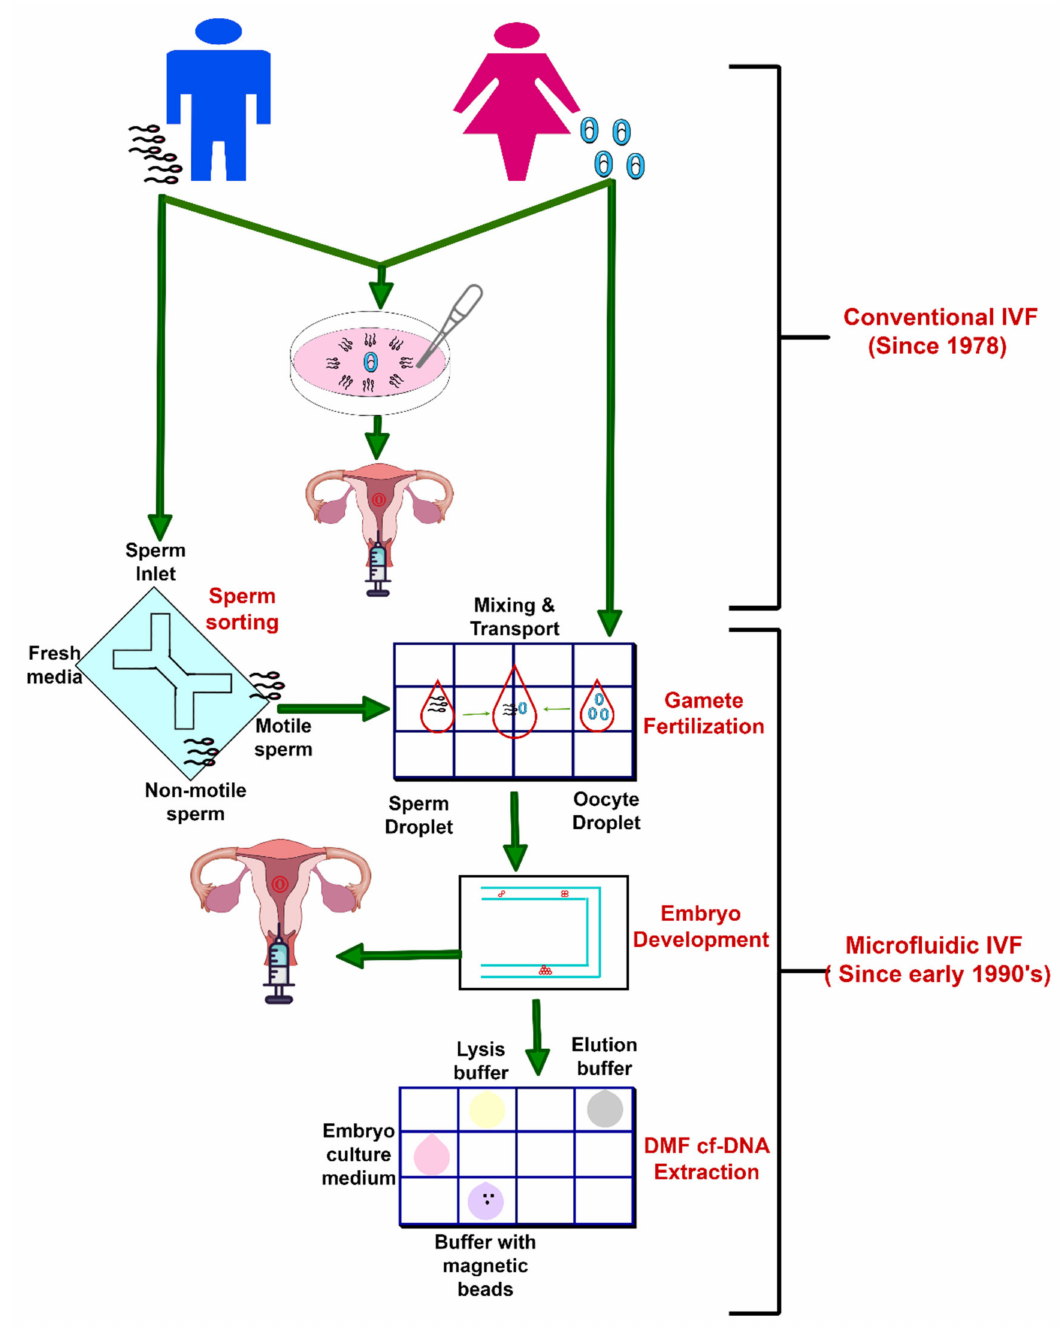
Figure 6. Conceptual diagram of conventional and microfluidic IVF for assistive reproductive